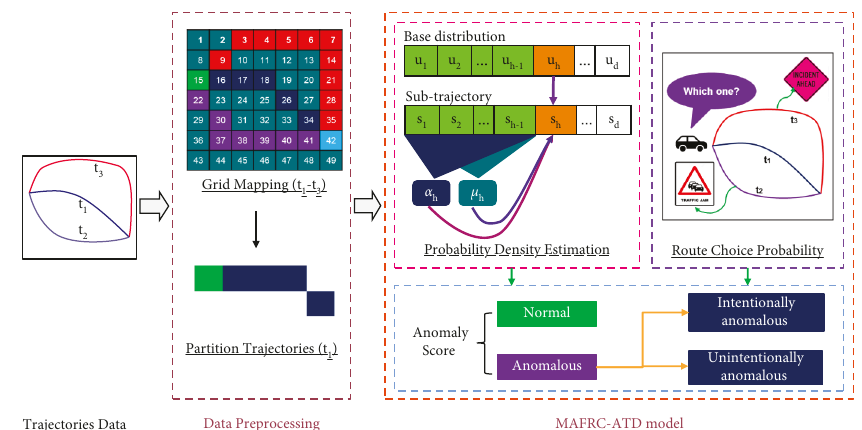
Figure 2: The overall architecture of MAFRC-ATD.